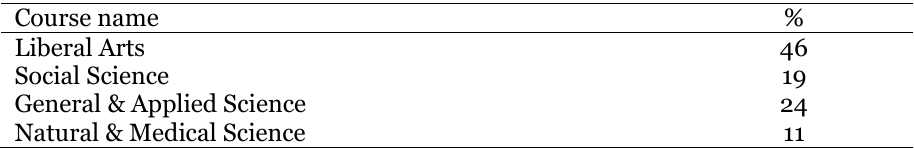
Disciplines of NTU OCW